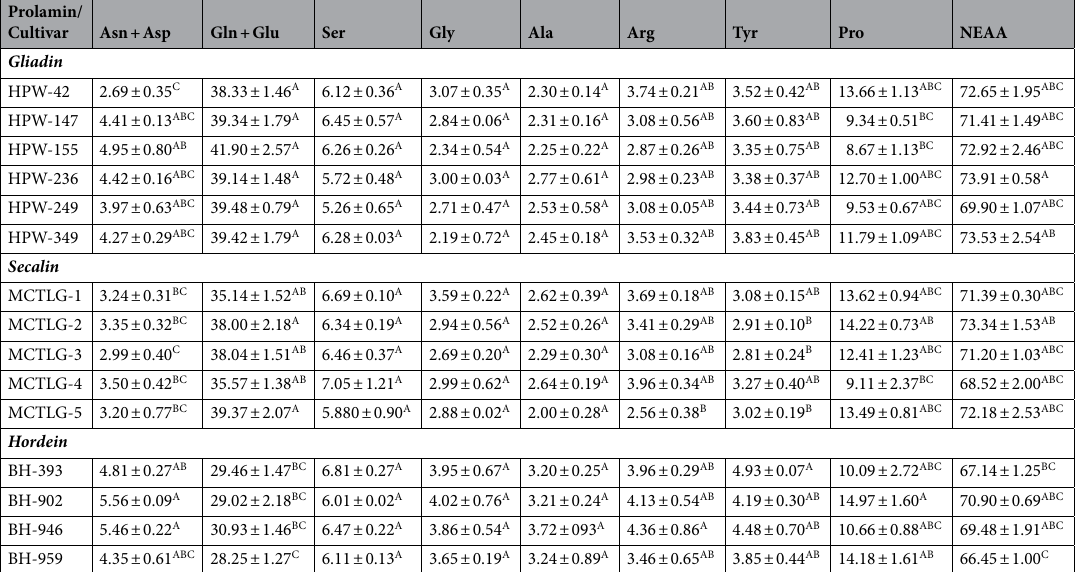
Table 3. Non-Essential Amino Acid (NEAA) Composition (g amino acid/100 g protein) of Gliadin, Secalin and Hordein Fractions. Asn + Asp – Asparagine + Aspartic Acid, Gln + Glu – Glutamine + Glutamic Acid, Ser – Serine, Gly – Glycine, Arg – Arginine, Ala – Alanine, Tyr – Tyrosine, Pro – Proline, TNEAA – Total Non- Essential Amino Acid. Mean ± SD with different superscripts in column differ significantly ( p ≤ 0.05); n = 3 for each